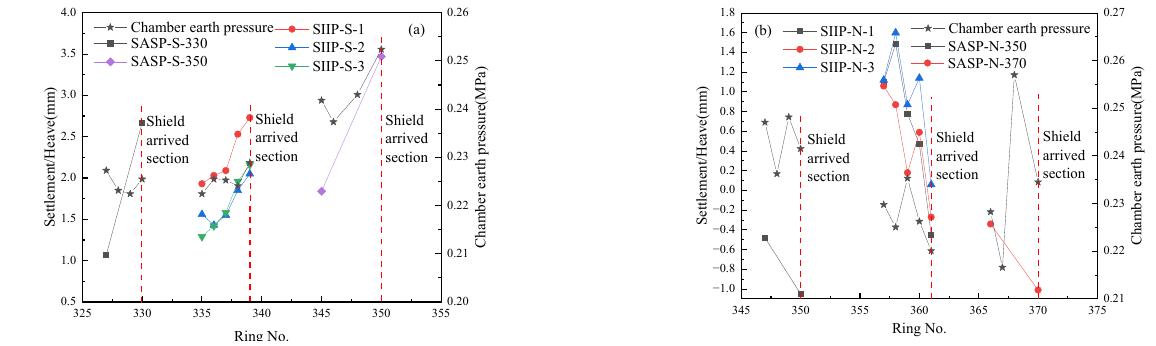
Figure 17. The relationship between chamber earth pressure and surface deformation: ( a ) south line; ( b ) north line.